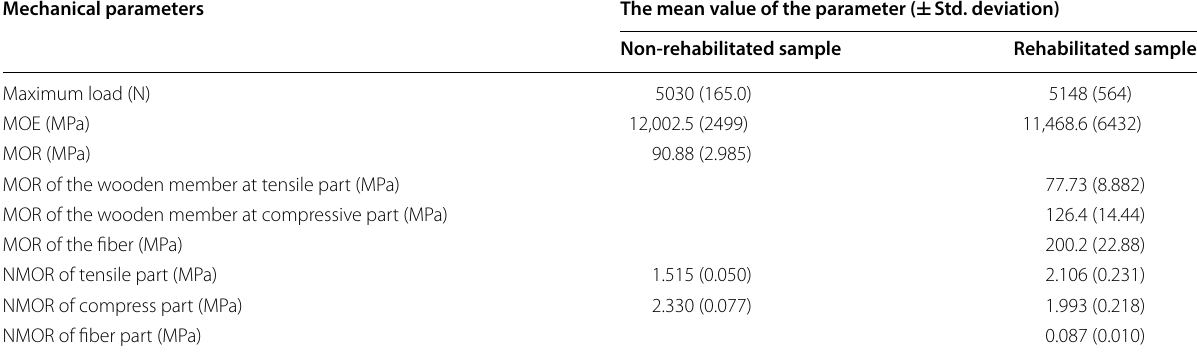
Table 3 The mean values of the mechanical properties Mechanical parameters The mean value of the parameter (